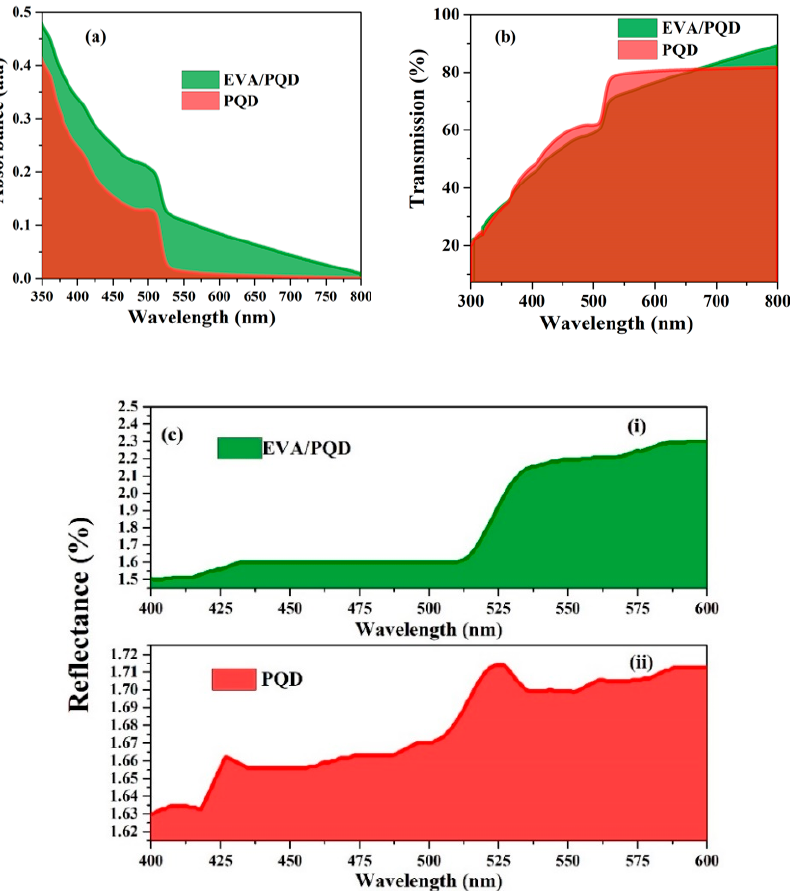
Figure 4. ( a – c ) Comparison of the absorbances, transmittances, and reflectances of the pure PQD and the EVA-TPR/PQD films.